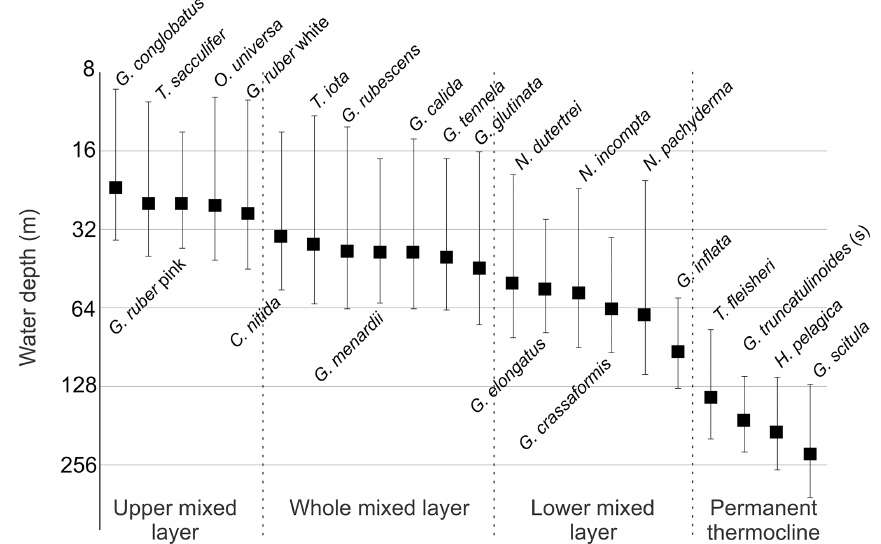
Figure 5. Average living depth (ALD) and vertical dispersion (VD) of the most abundant planktonic foraminifera species sorted by depth (in base 2 logarithmic scale) with the defined depth groups.